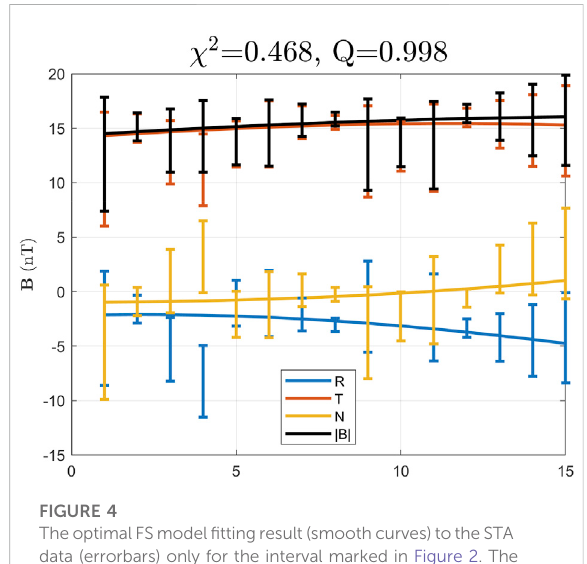
FIGURE 4 TheoptimalFSmodel fi ttingresult(smoothcurves)totheSTA data (errorbars) only for the interval marked in Figure 2. The corresponding minimum reduced χ 2 and Q values are denoted on top.Thehorizontalaxisindicatestheindicesofthedataarrays (15 data points